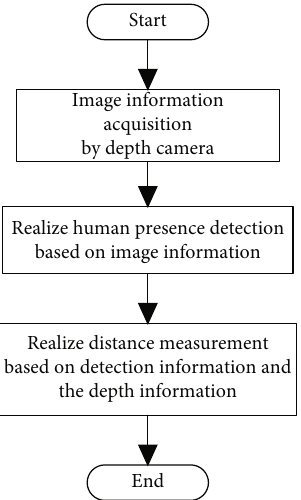
Figure 1: Human position detection process based on depth camera image